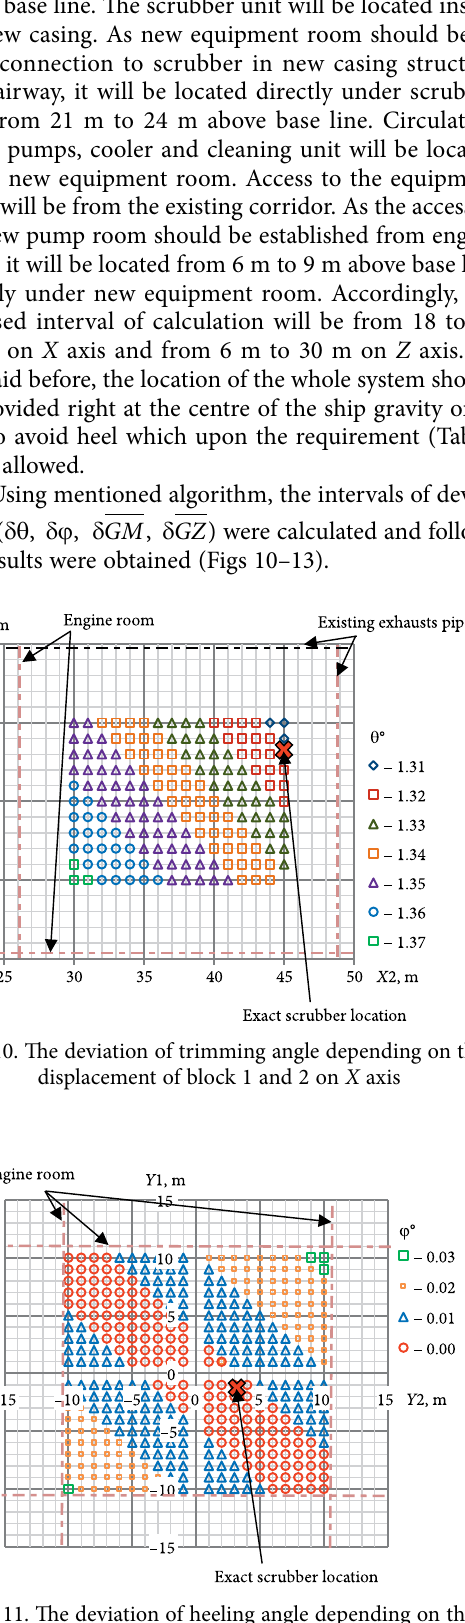
Fig. 11. The deviation of heeling angle depending on the displacement of block 1 and 2 on Y axis